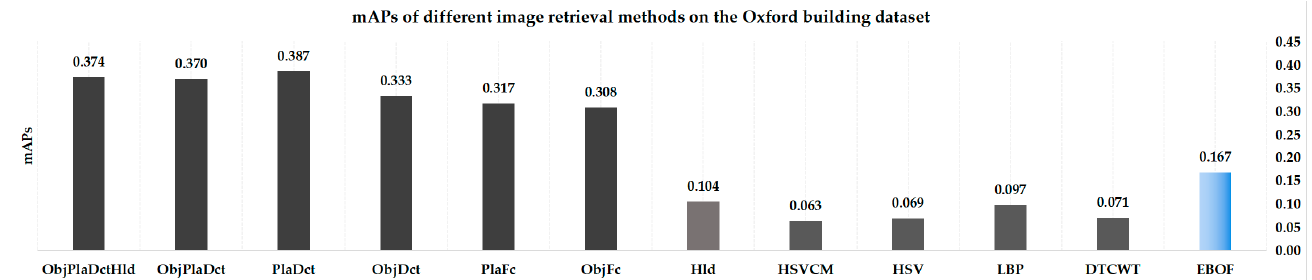
Figure 17. Boxplot of mAPs on the Oxford building dataset.